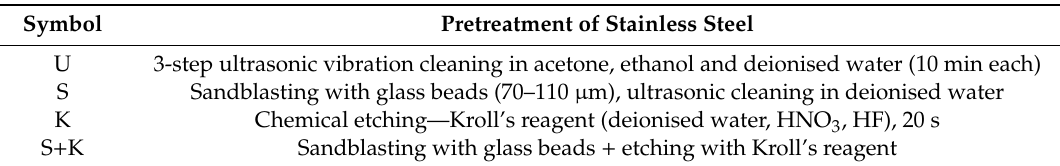
Table 1. The description of cleaning